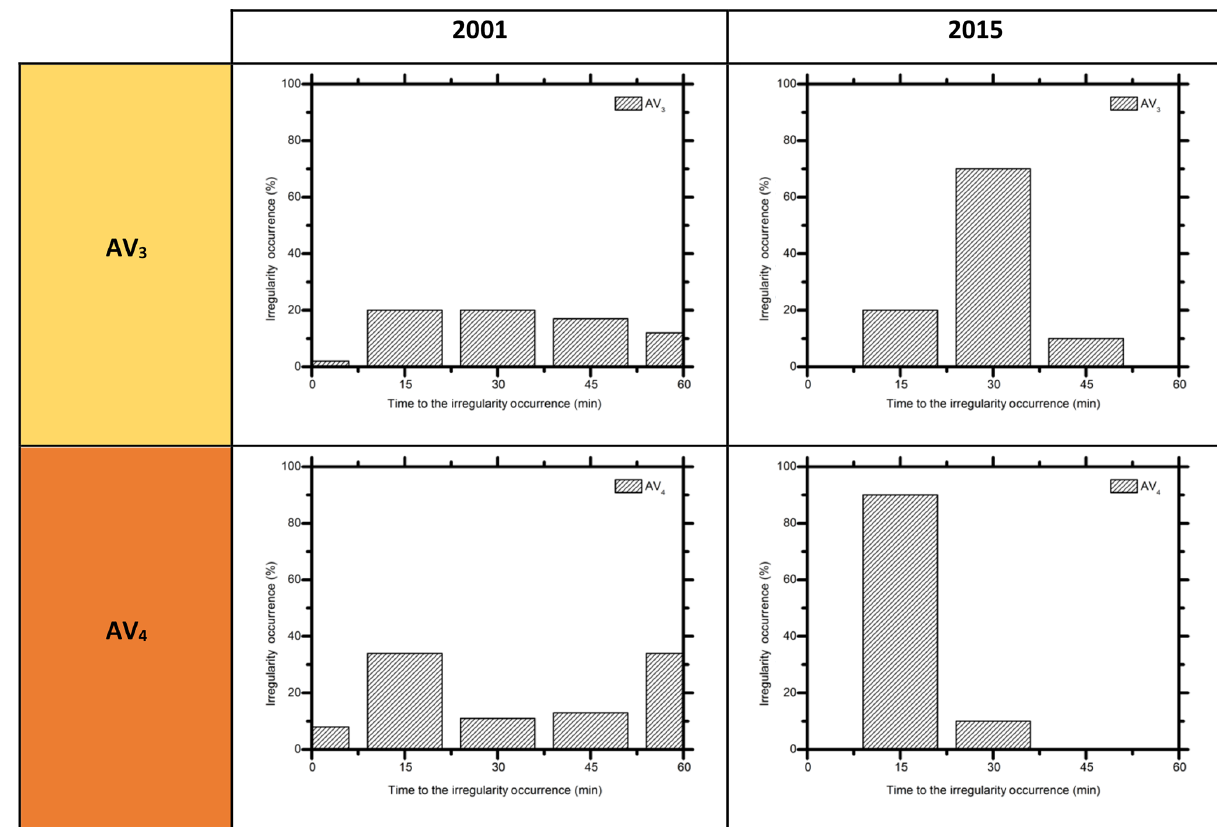
Figure 4. The time relationship between the V zp parameter, considering the AV 3 and AV 4 indexes, and the irregularity observations in ionograms in the equinoxes of 2001 and 2015 over São Luís. The V zp did not reach the AV 5